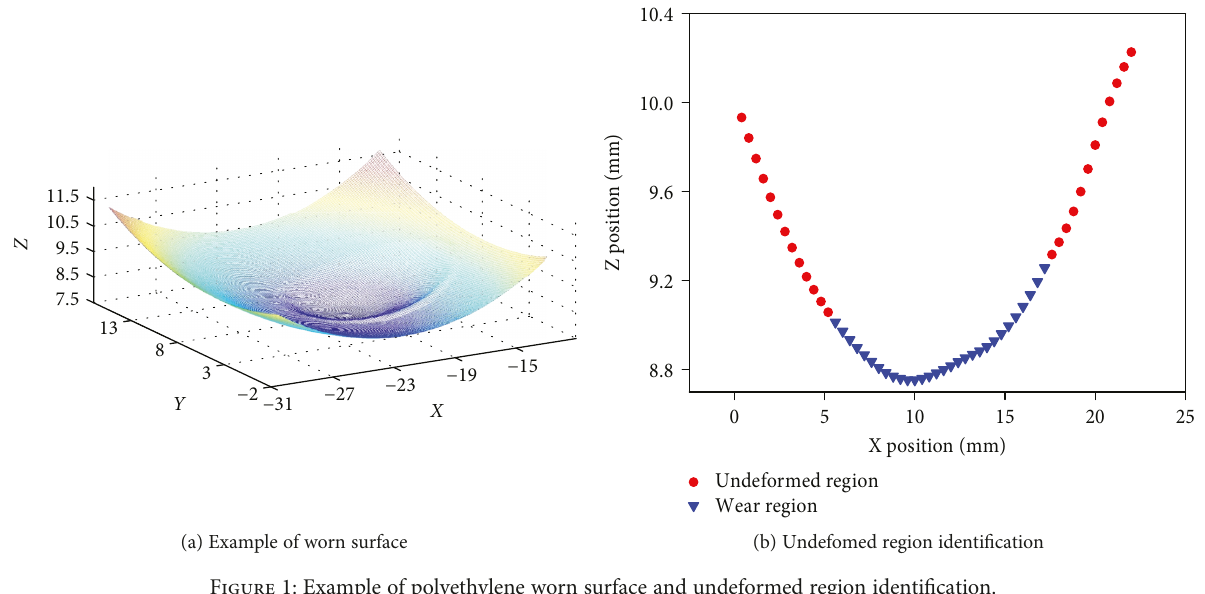
Figure 1: Example of polyethylene worn surface and undeformed region identi fi cation.